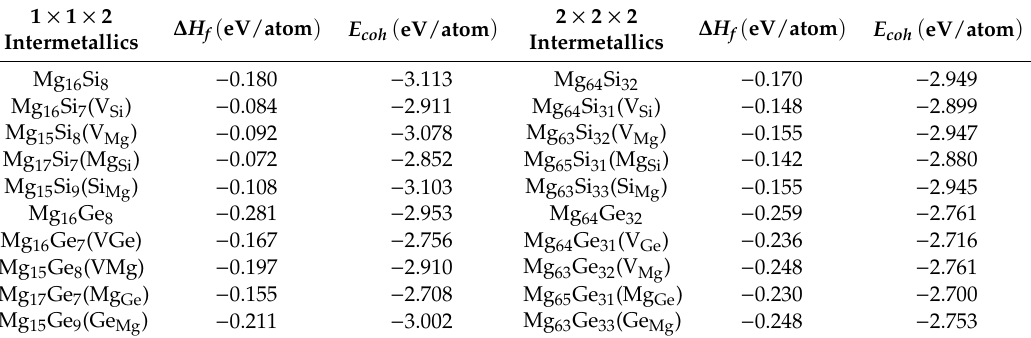
Table 3. Computed formation heat ( ∆ H f ) and binding energy ( E coh ) of Mg 16 X 8 and Mg 64 X 32 (X = Si, Ge) with or without (anti) vacancy point